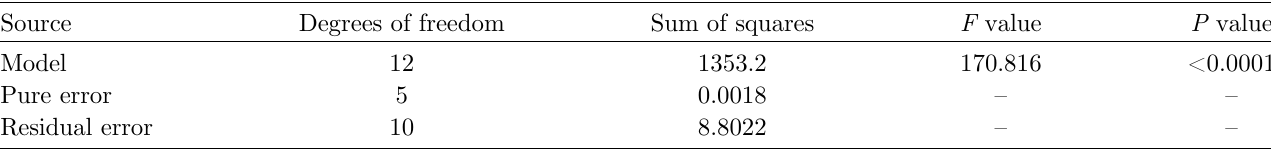
Table 5. ANOVA for quadratic model and regression statistics.